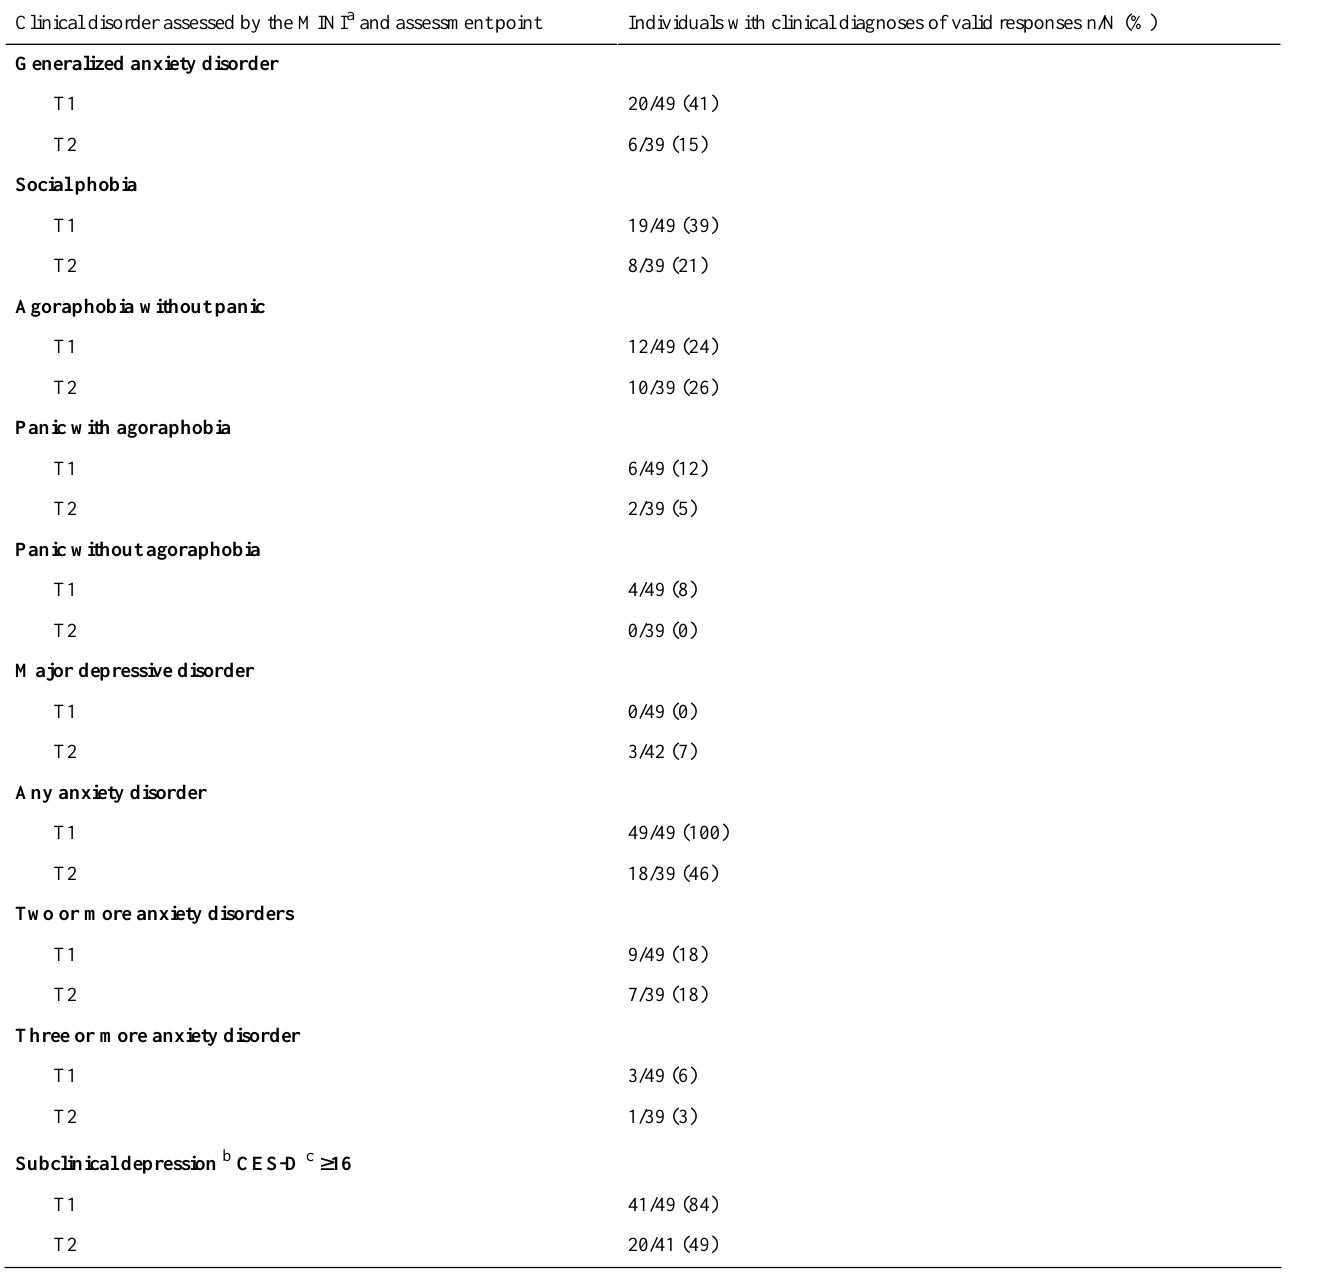
Table 4. Diagnostic status depression and